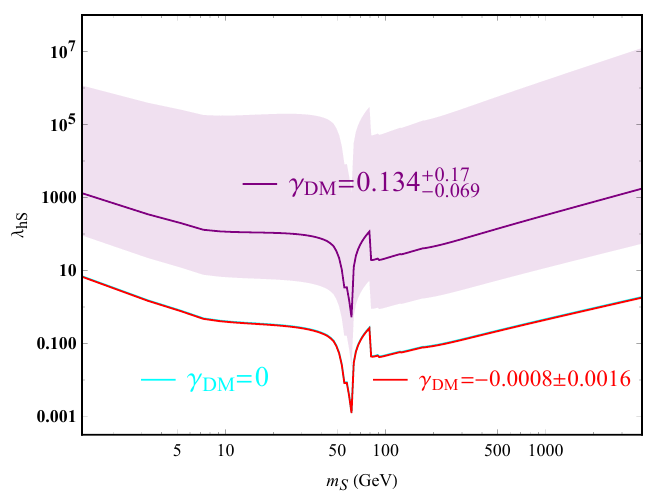
Figure 5 . Allowed parameter regions in the ( m S − λ h S ) plane under the constraint of dark matter relic density Ω h 2 = 0 . 1198 ± 0 . 0012